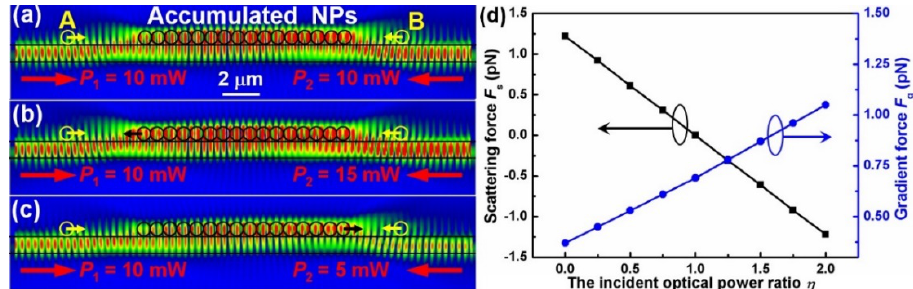
Figure 5. Simulation and calculation results for accumulation of the NPs and delivery along NF (keeping P 1 = 10 mW unchanged). ( a – c ) Simulated distributions of the optical field for three different input optical powers P 2 = 10 ( a ), 15 ( b ) and 5 mW ( c ). ( d ) Calculated forces F s and F g of the accumulated NPs in the accumulation region with different incident optical power ratios η (keeping P 1 = 10 mW